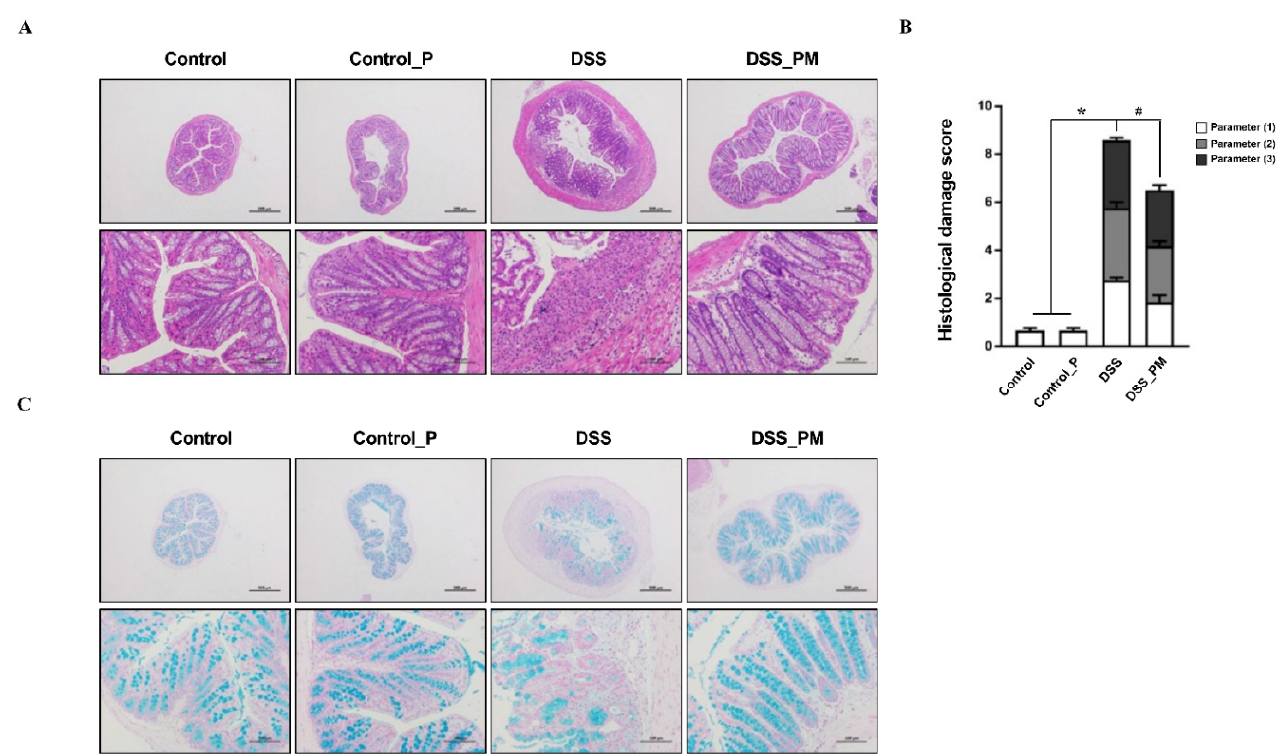
Figure 3. Pea albumin alleviated DSS-induced histological damage and mucus deficiency in colitis. ( A ) Representative H&E staining images of colonic tissue sections. Scale bar means 500 µ m (up) and 100 µ m (down). ( B ) Histopathological scores. Parameters (1): Loss of epithelial surface; Parameters (2): Destruction of crypt; Parameters (3): Infiltration of inflammatory cells. ( C ) Representative images of AB-stained inner mucus layer of colonic sections. Scale bars indicate 500 µ m (up) and 100 µ m (down). Data are shown as mean ± SEM. n = 9 per group. * p < 0.05 versus the control group. # p < 0.05 versus the DSS group. AB, Alcian blue; DSS, dextran sulfate sodium; Control_P, 0.75 g/kg body weight pea albumin by oral gavage; DSS_PM, 2.0% w / v DSS in drinking water + 0.75 g/kg body weight pea albumin by oral gavage.